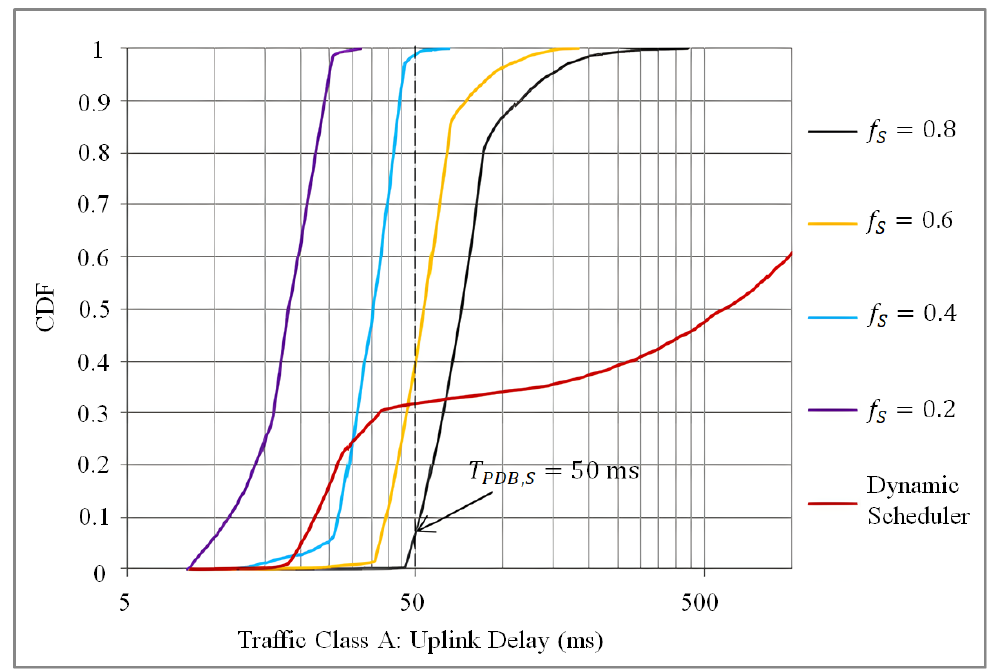
= 0.2 T PDB , S λ S